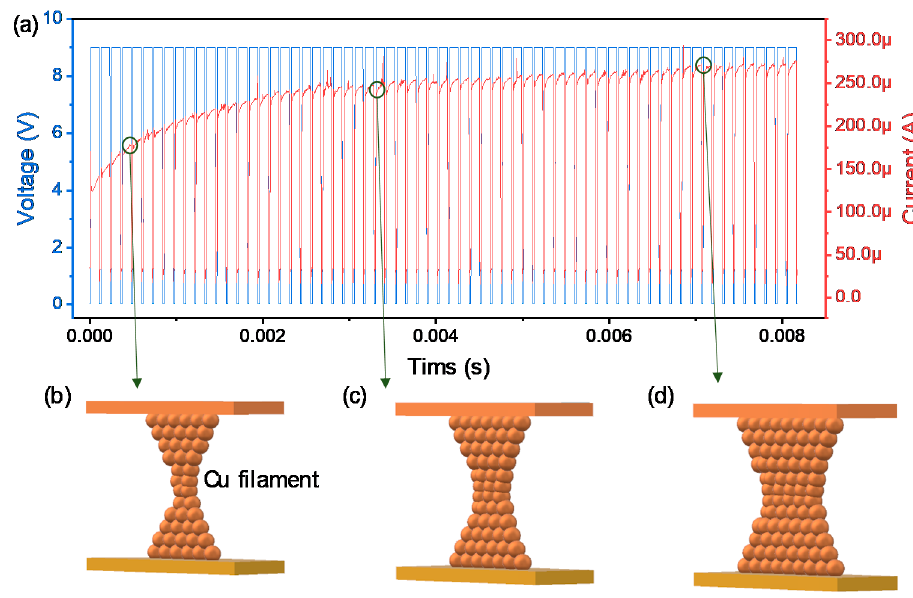
Figure 4. TransientcharacteristicsofCu / AlN / TiNdevicefor( a )LTP;SchematicsofCufilamentgrowing( b – d Figure 4. Transient characteristics of Cu/AlN/TiN device for ( a ) LTP; Schematics of Cu filament growing ( b – d ).